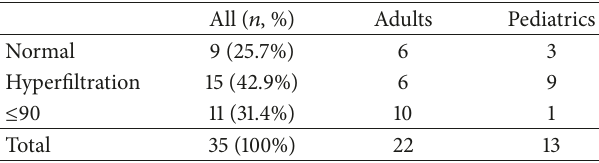
Table 4: Other organic